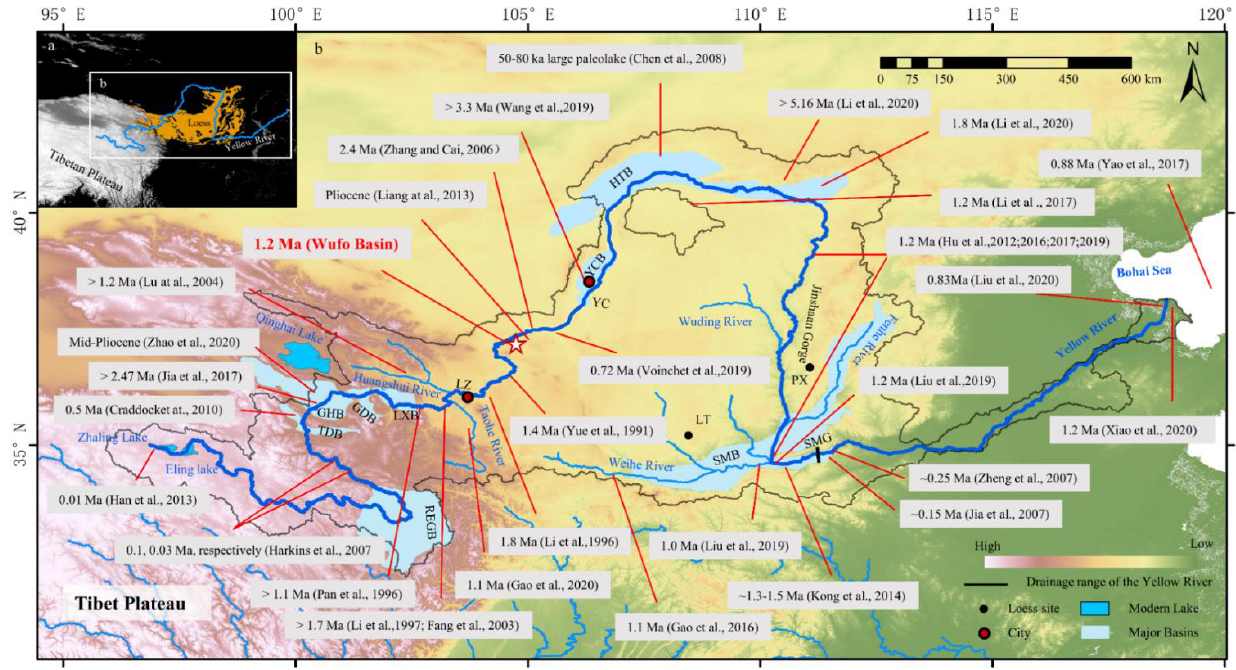
Figure 1. Study area of the Wufo Basin (red star) with the background of the Yellow River catchment. ( a ) Topography of the Yellow River catchment presented by Digital Elevation Model (DEM) data (SRTM V4 90 m resolution), and the extension of loess deposit in north China. ( b ) Overview of the Yellow River drainage and major basins along the Yellow River valley with the background of morphologic features expressed by DEM data (SRTM V4 90 m resolution data). Red lines point to the previous study areas with references marked in the grey boxes. Black lines mean the boundary of the Yellow River catchment. Dark blue polygons indicate the modern lakes and light blue polygons indicate basins that were once occupied by paleo-lakes. REGB: Ruoergai Basin; TDB: Tongde Basin; GHB: Gonghe Basin; GDB: Guide Basin; LXB: Linxia Basin; YCB: Yinchuan Basin; HTB: Hetao Basin; SMB: Sanmen Basin; SMG: Sanmen Gorge; LZ: Lanzhou City; YC: Yinchuan City; LT and PX are LingTai and PuXian loess site, respectively.